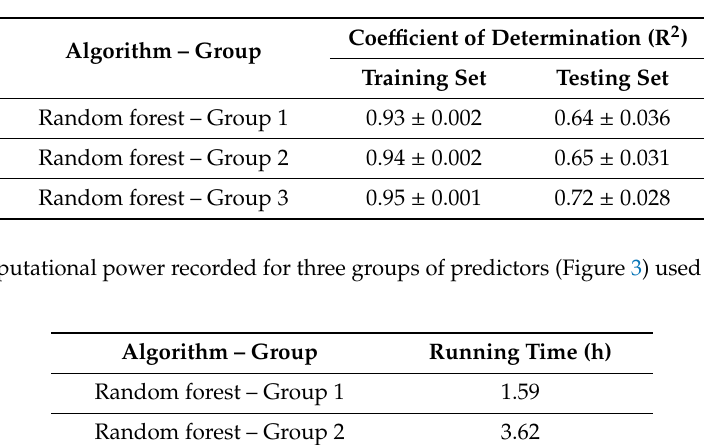
Table 11. R 2 (mean ± standard deviation) of annual EUI for training and testing sets of three groups of predictors (Figure 3) used in the Random Forest model.